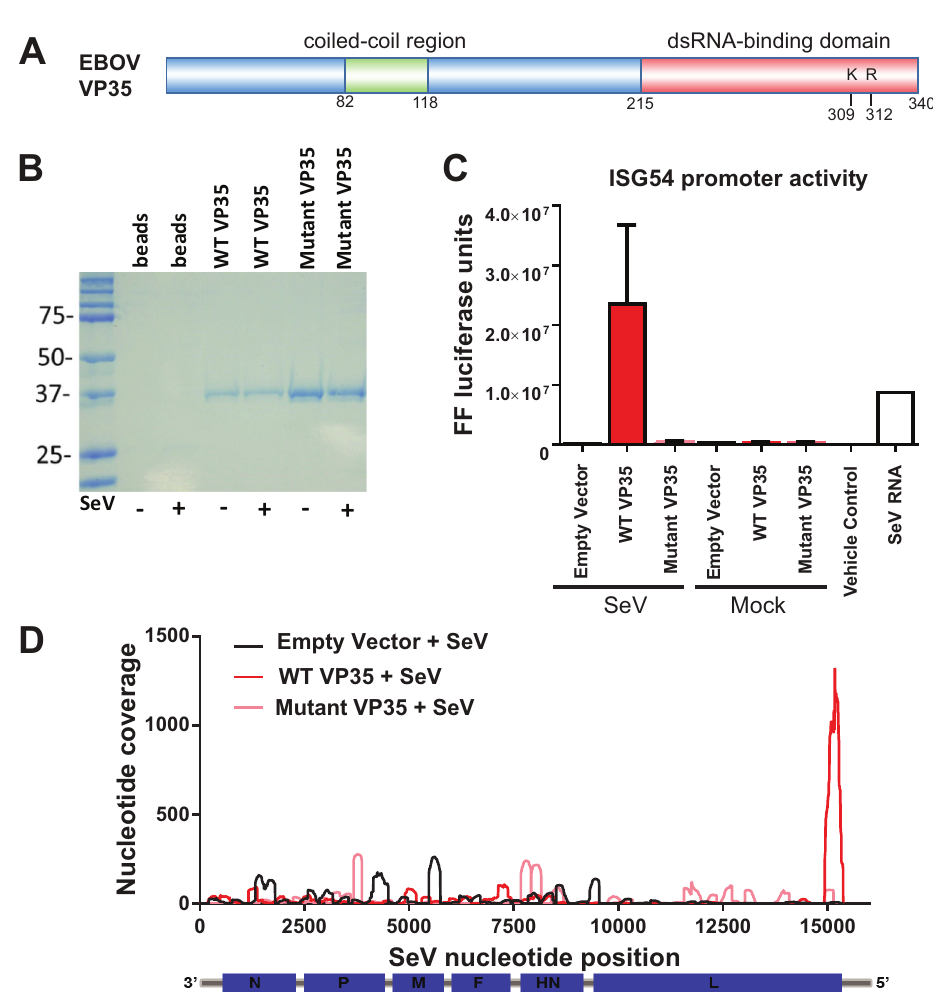
Fig 3. Mutations in VP35important for dsRNAbinding abrogate its ability to bind the immunostimulatory SeVDI. (A) Schematic of theEBOV VP35proteincontaininga coiled-coil domainimportantfor oligomerizationin the N-terminal halfof the proteinanddsRNA-bindingdomaininthe C-terminalhalf.ResiduesK309andR312were mutatedto alanineto generatethe EBOVVP35RNA-bindingmutant.(B) Proteinstainingof immunoprecipitated FLAG-taggedwild-typeandmutantVP35fromwhichthe RNAtransfected in (C) andsequencedin (D) were recovered. (C) Immunostimulatoryactivityof RNAfollowingimmunoprecipitationof the pCAGGSemptyvector (EV), wild-typeEBOV VP35,andmutantEBOV VP35in cellsinfectedwithSeVor mock-infected. (D) Next- generation sequencingandreadmappingto theSeVgenome.RNAassociated withthe pCAGGSemptyvector, wild-typeEBOV VP35,andmutantEBOV VP35waspurifiedandsubjected to Illuminasequencingandthe resultingreadsweremappedto the SeVgenome.Thegraphdepictsnucleotidecoverage (Y-axis)at eachposition of the